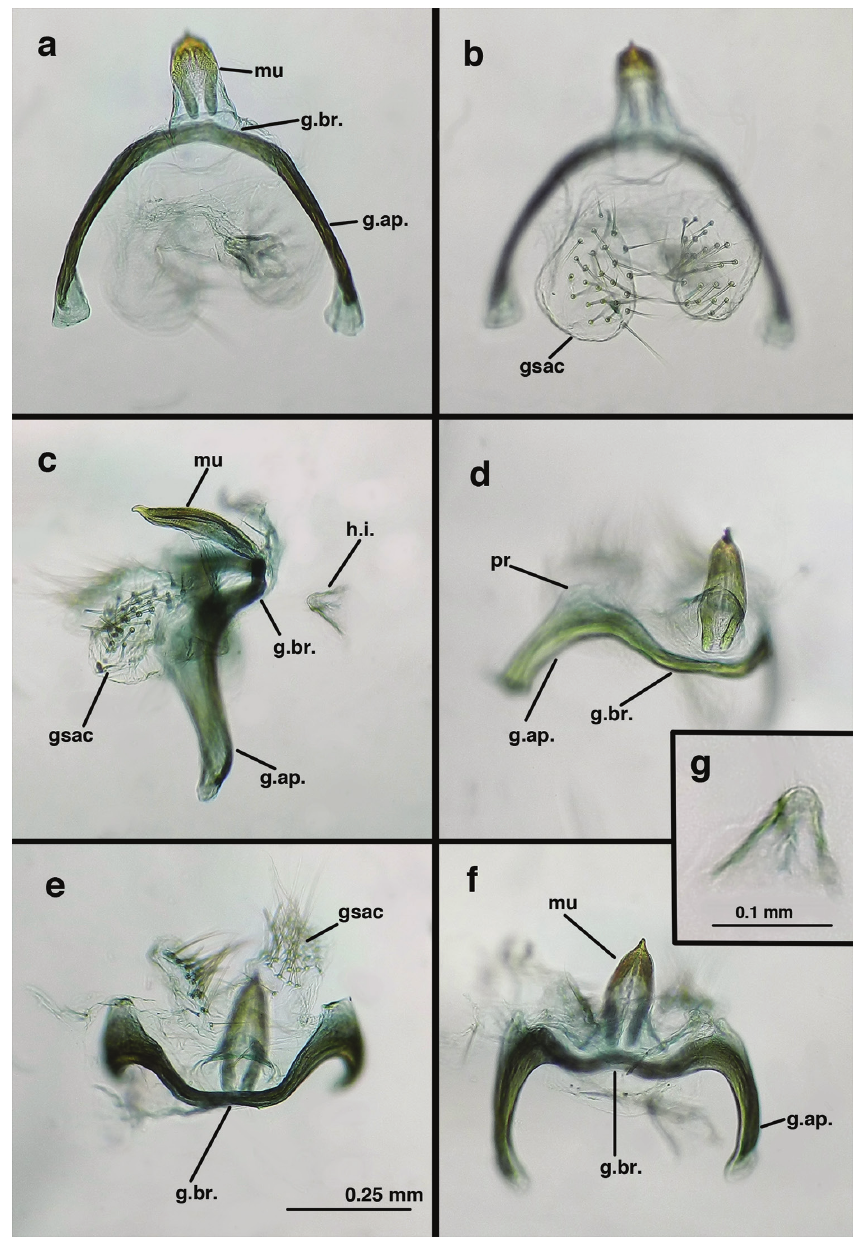
Figure 136. Ungla ivancruzi Freitas: Male genitalia, ( a ) gonarcus and mediuncal base, posterior ( b ) setose gonosaccus, expanded, frontal ( c ) gonarcus with hypandrium internum, lateral [Note relative size of hyp- andrium internum.] ( d ) mediuncus, gonarcus, dorsal to dorsolateral ( e ) gonarcus, frontodorsal ( f ) gonar- cus, posterodorsal ( g ) hypandrium internum. gsac gonosaccus g.ap. gonarcal apodeme g.br. gonarcal bridge h.i. hypandrium internum mu mediuncus pr unarticulated process on frontal margin of gonarcal apodeme (Brazil, Minas Gerais, from original type series or their offspring, MJMO; images